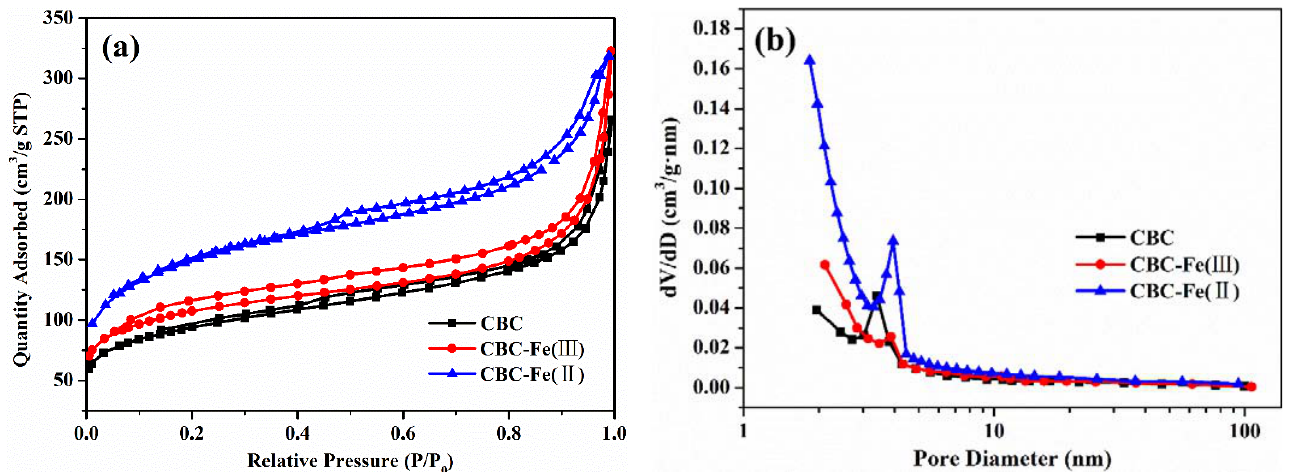
Figure 4. ( a ) N 2 adsorption–desorption isotherms and ( b ) pore size distributions of CBC, CBC ‐ Fe(III) and CBC ‐ Fe(II). Table 1. BET surface area and pore parameters of CBC, CBC ‐ Fe(III) and CBC ‐ Fe(II).